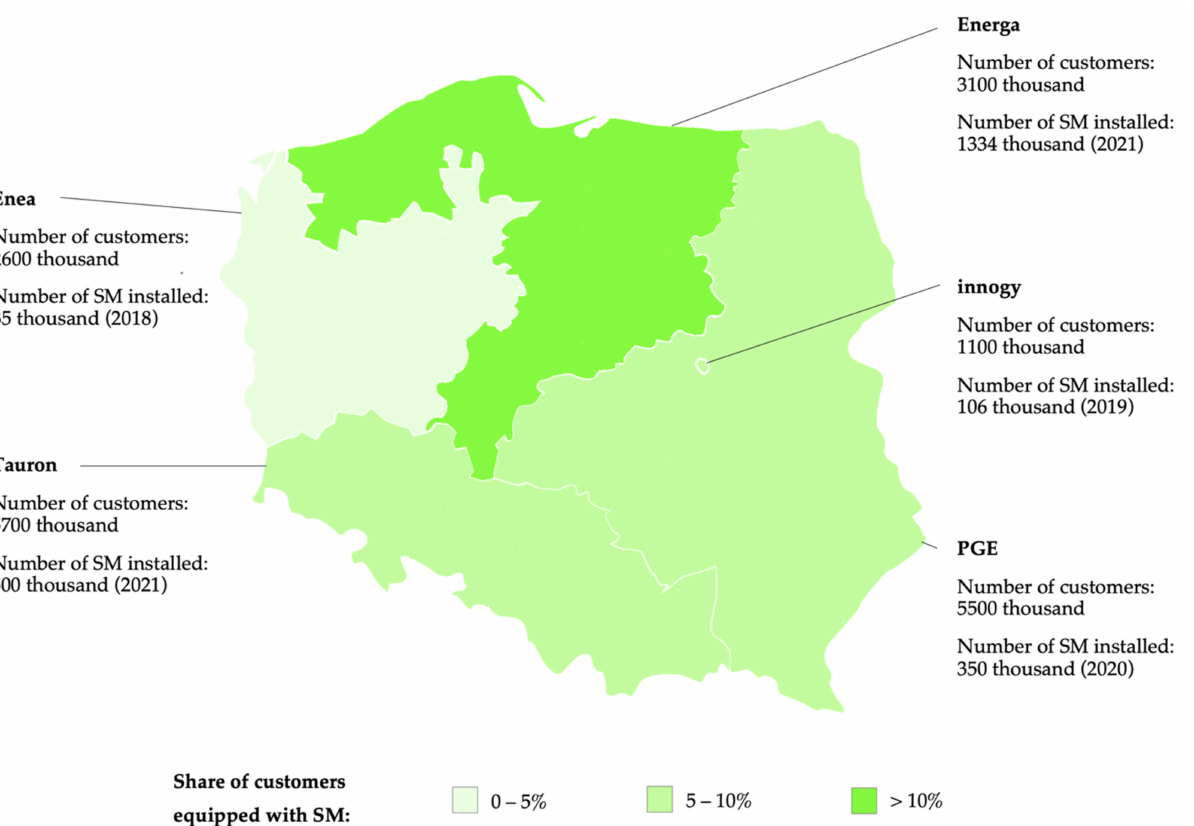
Figure 4. SM penetration in the power grids of the five main DSOs in